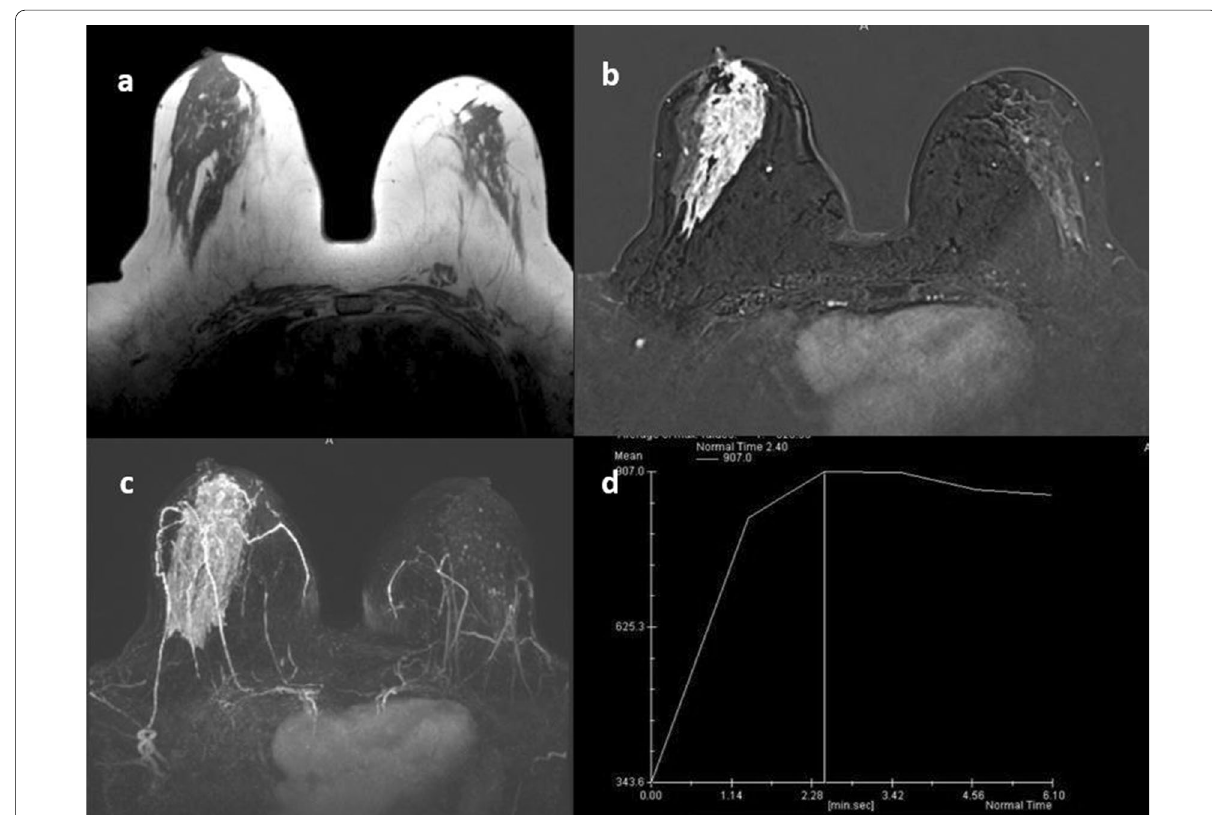
Fig. 4 A 53‑year‑old patient presented with Rt. breast nipple discharge. Pathological and immunohistochemical assessment revealed a ductal in situ mammary carcinoma and luminal B type (HER2 ve). ITGB1FC 2.89. a MRI T2WIs b T1 fat‑suppression post‑contrast subtracted image + = c Maximum intensity projection (MIP) image shows a large regional area of non‑mass enhancement at the lower‑outer quadrant right breast extending to the retro‑ areolar region showing clumped pattern of internal enhancement d Type II time intensity curve. Normal MRI appearance of the left